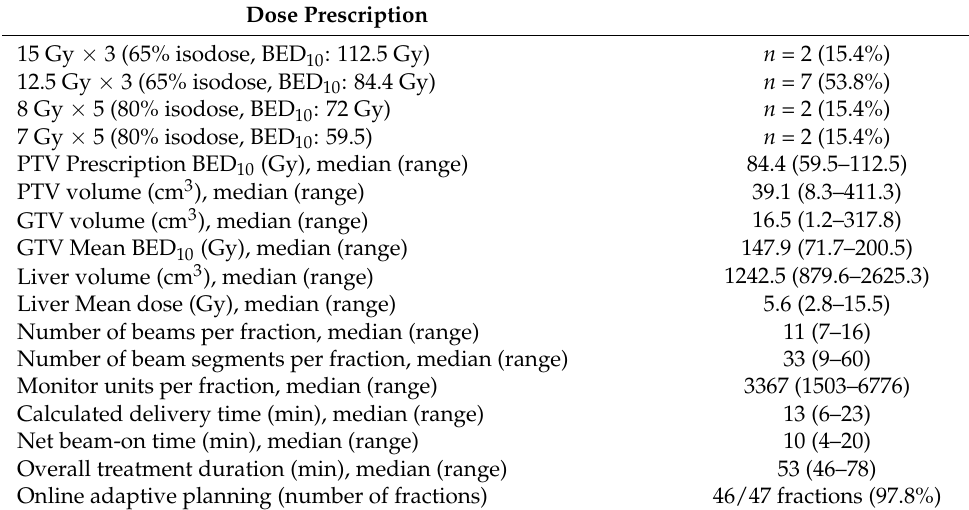
Table 2. Treatment